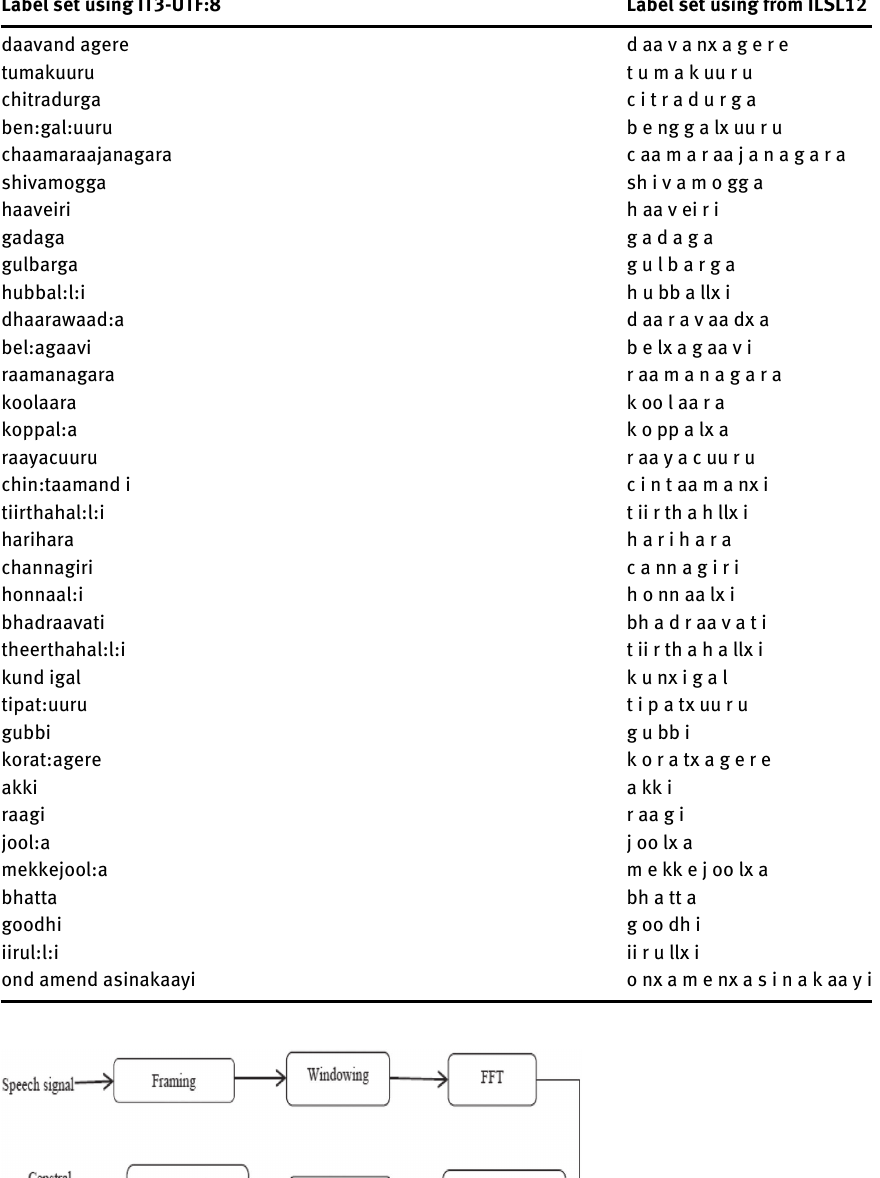
Table 16: Dictionary/Lexicon for Some of Districts, Mandis, and Commodities Enlisted in AGMARKNET. Label set using IT3-UTF:8 Label set using from ILSL12